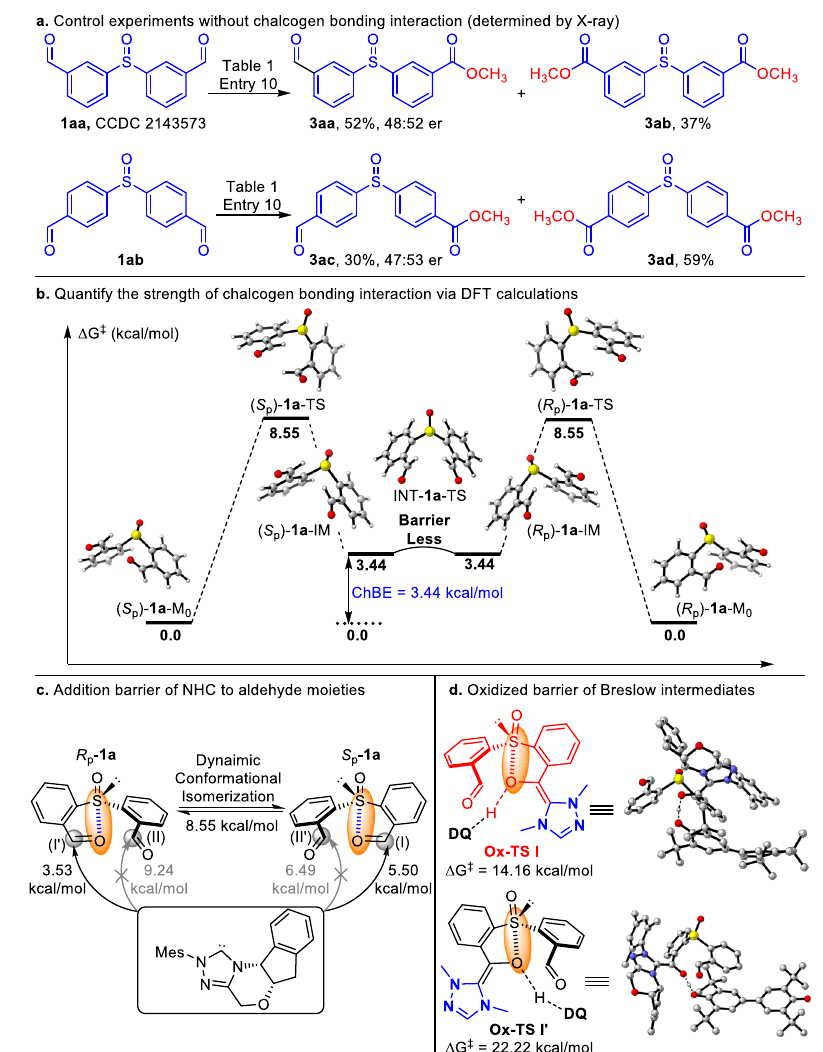
Fig.4|Mechanisticstudies.a Controlexperimentswithoutchalcogenbondinginteraction. b QuantifythestrengthofchalcogenbondinginteractionviaDFTcalculations. c Addition barrier of NHC to aldehyde moieties. d Oxidized barrier of Breslow